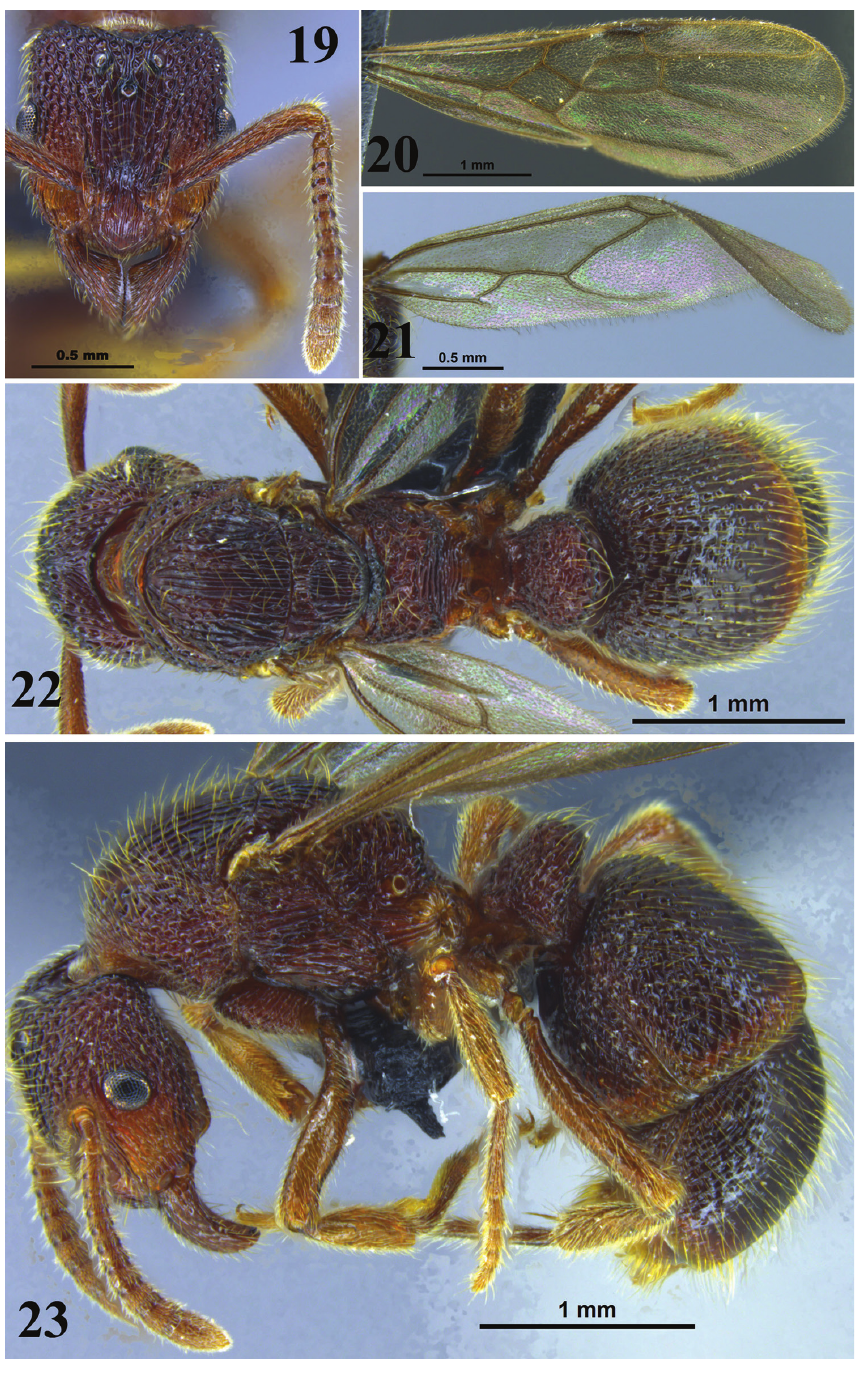
Figures 19−23. Gnamptogenys quadrutinodules paratype queen (No. G120081). 19 head in full-face view 20 forewing in dorsal view 21 hindwing in dorsal view 22 body in dorsal view 23 body in lateral